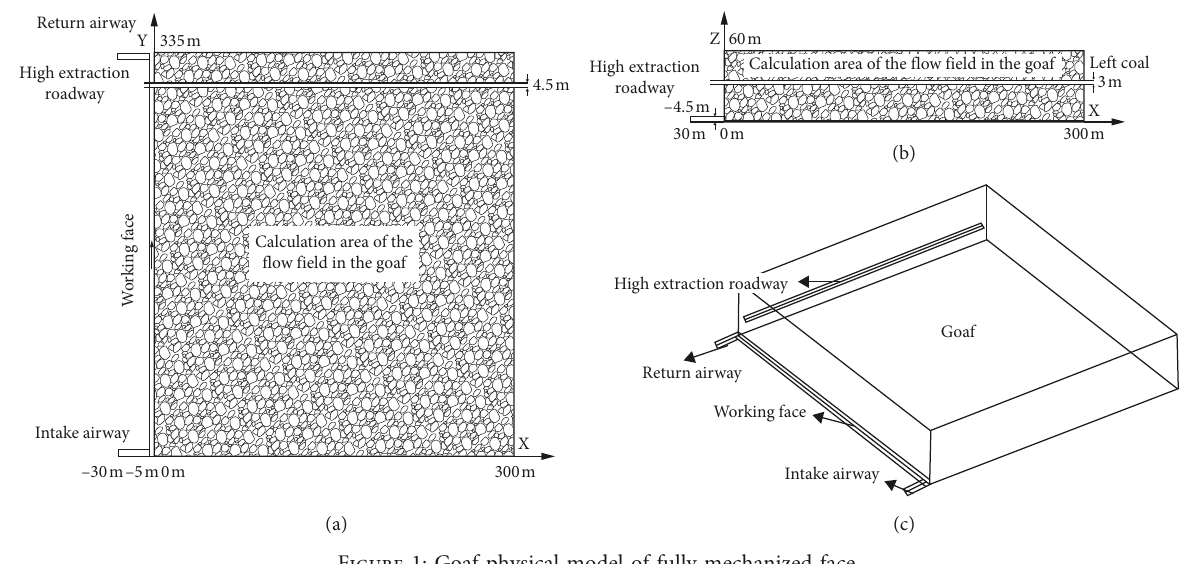
Figure 1: Goaf physical model of fully mechanized